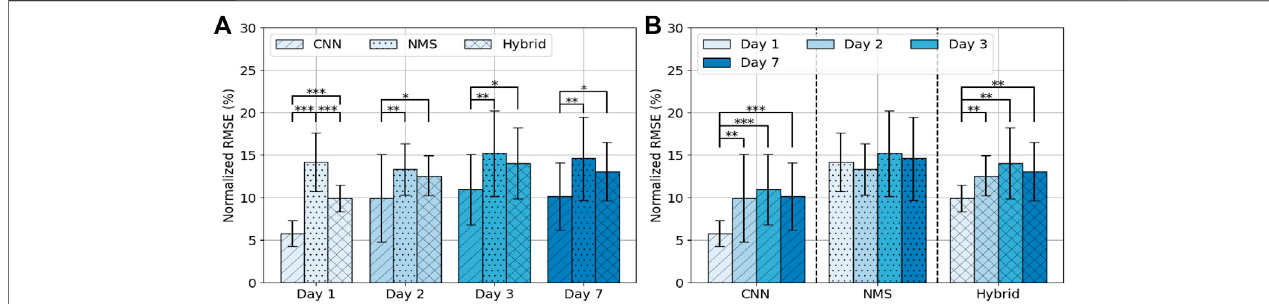
FIGURE4| AverageNRMSE(±SD)perdaypermodel (A) andpermodelperday (B) .Asterisksindicatesigni fi cancelevel: p < 0.05=*, p < 0.01=**, p < 0.001=***.